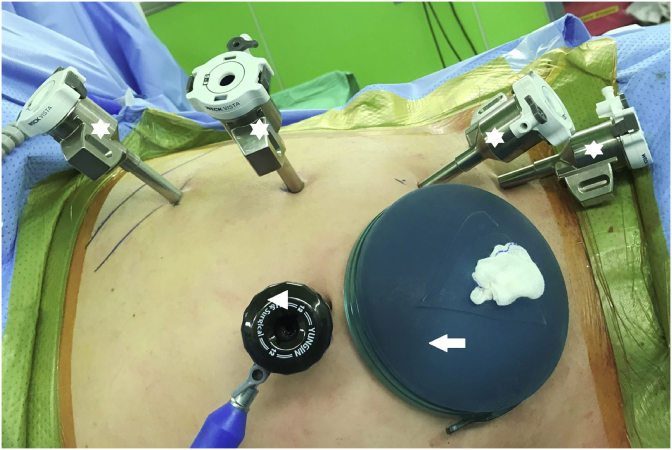
Our ports placement of RALDN approach (four 8 mm robotic ports; white star, 12 mm port at the upper umbilicus; white arrowhead, 8 cm hand GelPort at the lower umbilicus; white arrow).